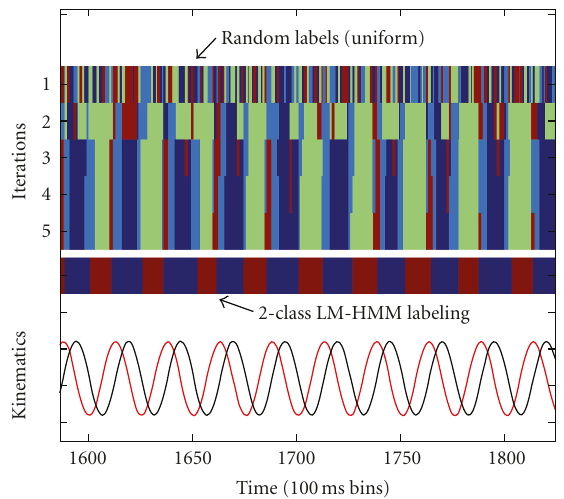
Figure 12: Classification degradation with increased random